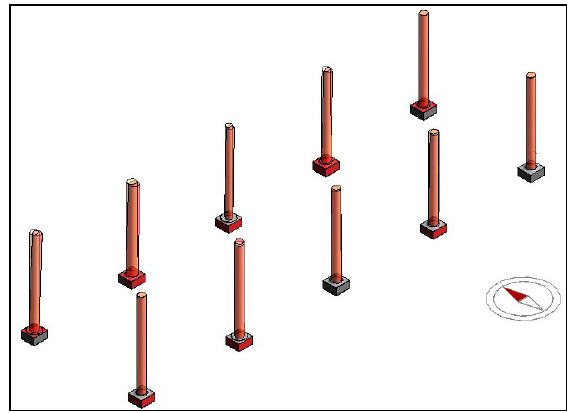
Figure 24 Representation of tilting and settlement of columns via linked shadow